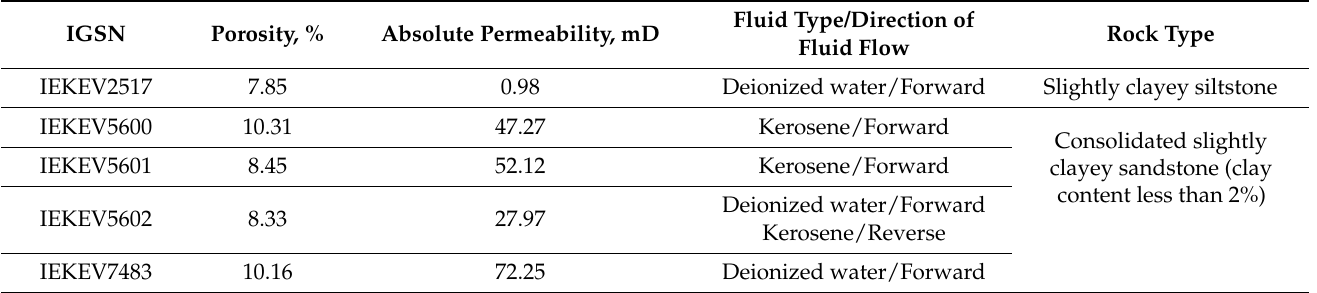
Table 1. Properties of core